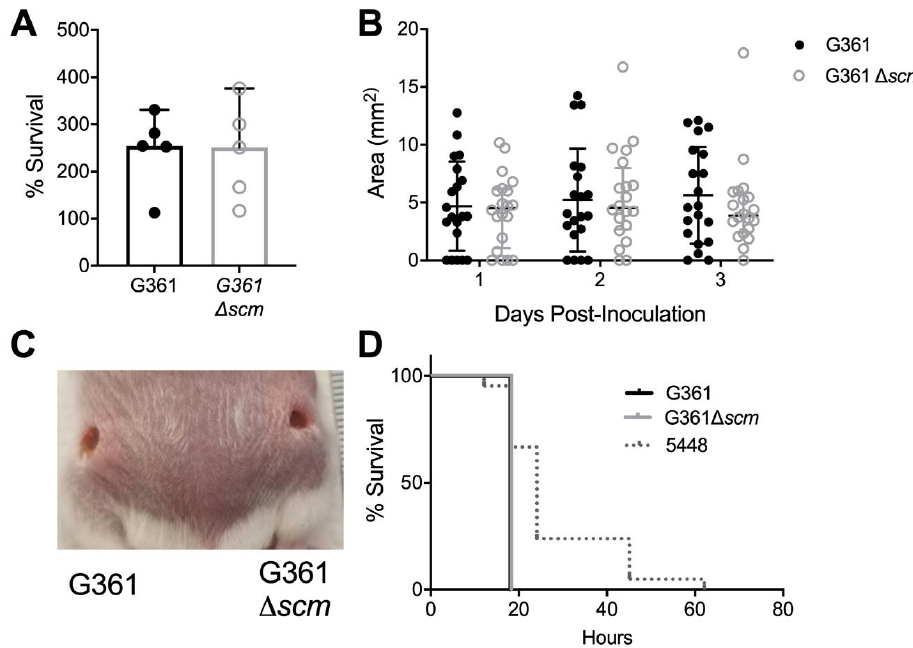
Figure 3. S. canis is highly virulent in mouse models of systemic and dermal infection, yet SCM does not contribute to virulence in these models. ( A ) Percent survival of S. canis G361 or G361Δ scm after 30 min of infection in murine whole blood collected from CD1 mice. ( B ) CD1 male and female mice were infected subcutaneously with 1 × 10 8 CFU of WT S. canis G361 or G361Δ scm and skin lesion size measured daily. ( C ) Representative image of skin lesions three days post subcutaneous infection with WT S. canis G361 (left) or G361Δ scm (right). ( D ) CD1 male and female mice were infected intraperitoneally with 5 × 10 7 CFU of WT S. canis G361, G361Δ scm , or S. pyogenes 5448 and survival monitored over 3 days. Symbols represent biological replicates (( A ), n = 5/group, ( B ), n = 20/group, and ( D ), n = 10-21/group) with lines indicating medians and interquartile ranges ( A , B ) or percentage survival ( D ). Data were analyzed by Wilcoxon matched-pairs signed rank test ( A ), two- way ANOVA with Sidak’s multiple comparisons post -test ( B ) or Log rank Mantel-Cox test ( D ) and determined not significant.